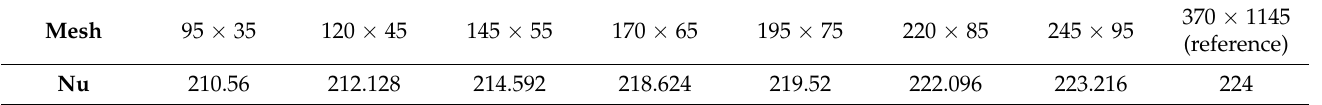
Table 1. Influence of mesh size on Nu, at Re = 8.73 × 10 4